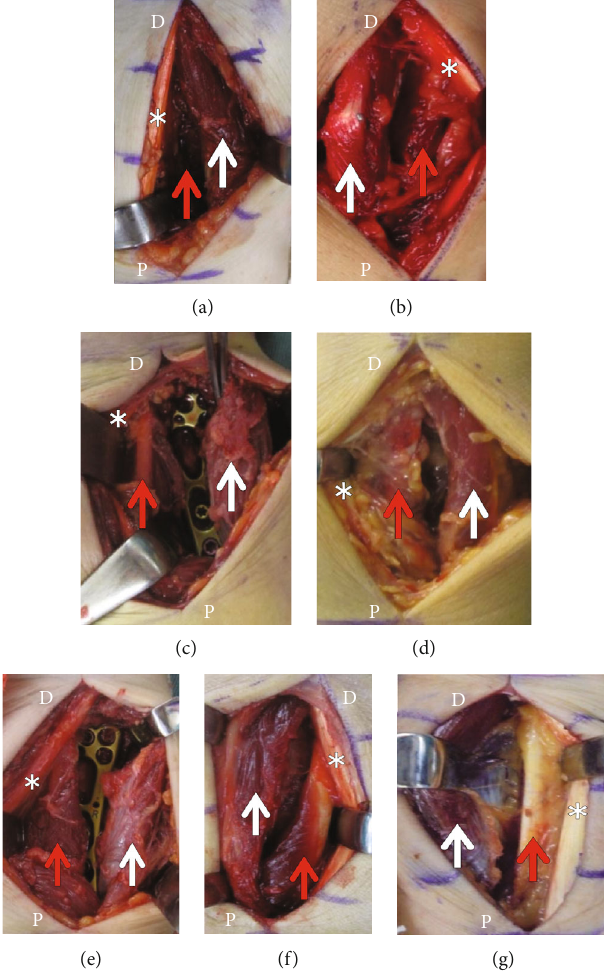
Figure 1: Intraoperative photographs: (a) case 1; (b) case 2; (c) case 3; (d) case 4; (e) case 5; (f) case 6; (g) case 7. D: distal limit of the incision; P: proximal limit of the incision; white arrow: fl exor carpi radialis brevis; red arrow: fl exor pollicis longus; asterisk: fl exor carpi radialis